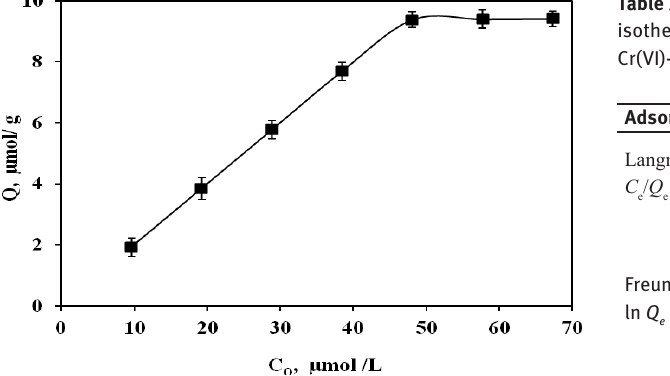
Figure 6: Adsorption isotherm curve of µSiO aqueous solutions. Experimental conditions: 10 mL sample volume, 50 mg sorbent, pH 3, at temperature 25°C.